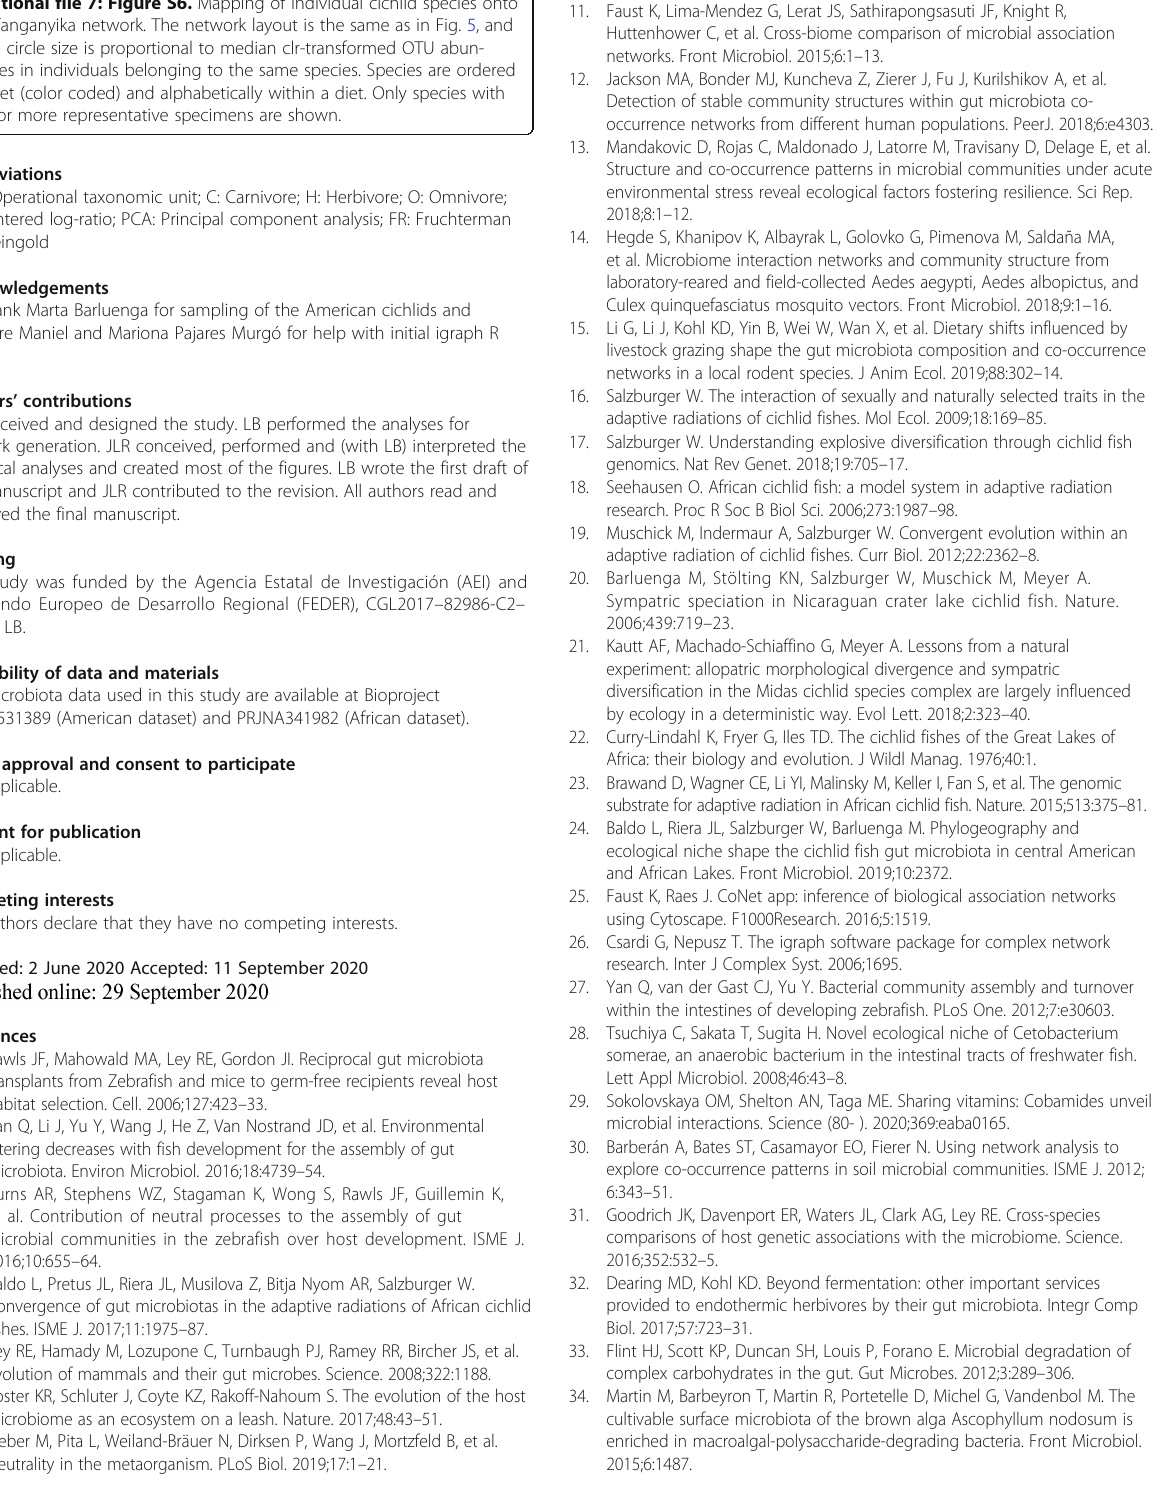
Additional file 6: Figure S5. Mapping of diet contribution onto the L. Tanganyika co-occurrence network based on the original PCA layout. Node size displays median clr-transformed OTU counts by diet, with filled (hollow) nodes signifying OTUs that are more (less) abundant than the sample geometric mean, as in Fig. 5. Additional file 7: Figure S6. Mapping of individual cichlid species onto the Tanganyika network. The network layout is the same as in Fig. 5, and node circle size is proportional to median clr-transformed OTU abun- dances in individuals belonging to the same species. Species are ordered by diet (color coded) and alphabetically within a diet. Only species with two or more representative specimens are shown. Abbreviations OTU: Operational taxonomic unit; C: Carnivore; H: Herbivore; O: Omnivore; clr: Centered log-ratio; PCA: Principal component analysis; FR: